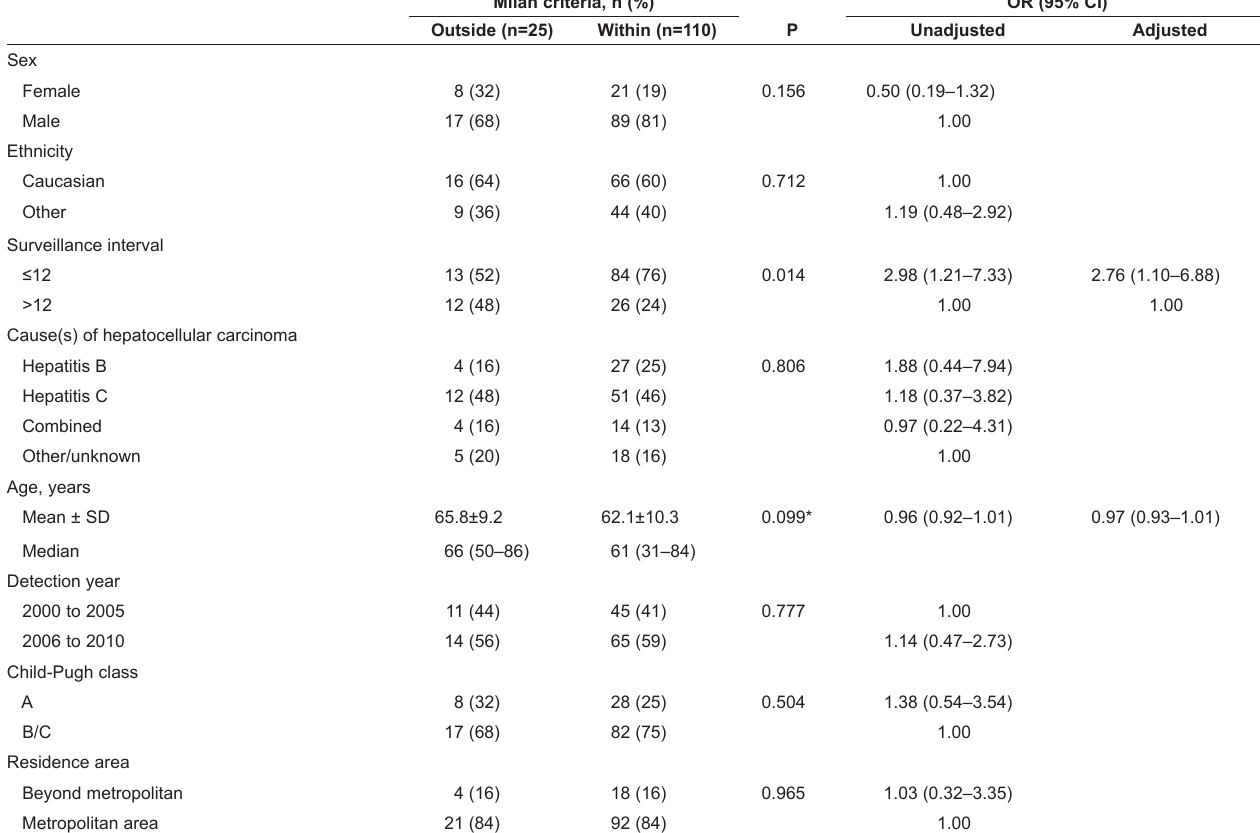
TABlE 5 Univariate and multivariate analysis of potential determinants of success of hepatocellular carcinoma ultrasound surveillance using Milan criteria for liver transplantation Milan criteria, n